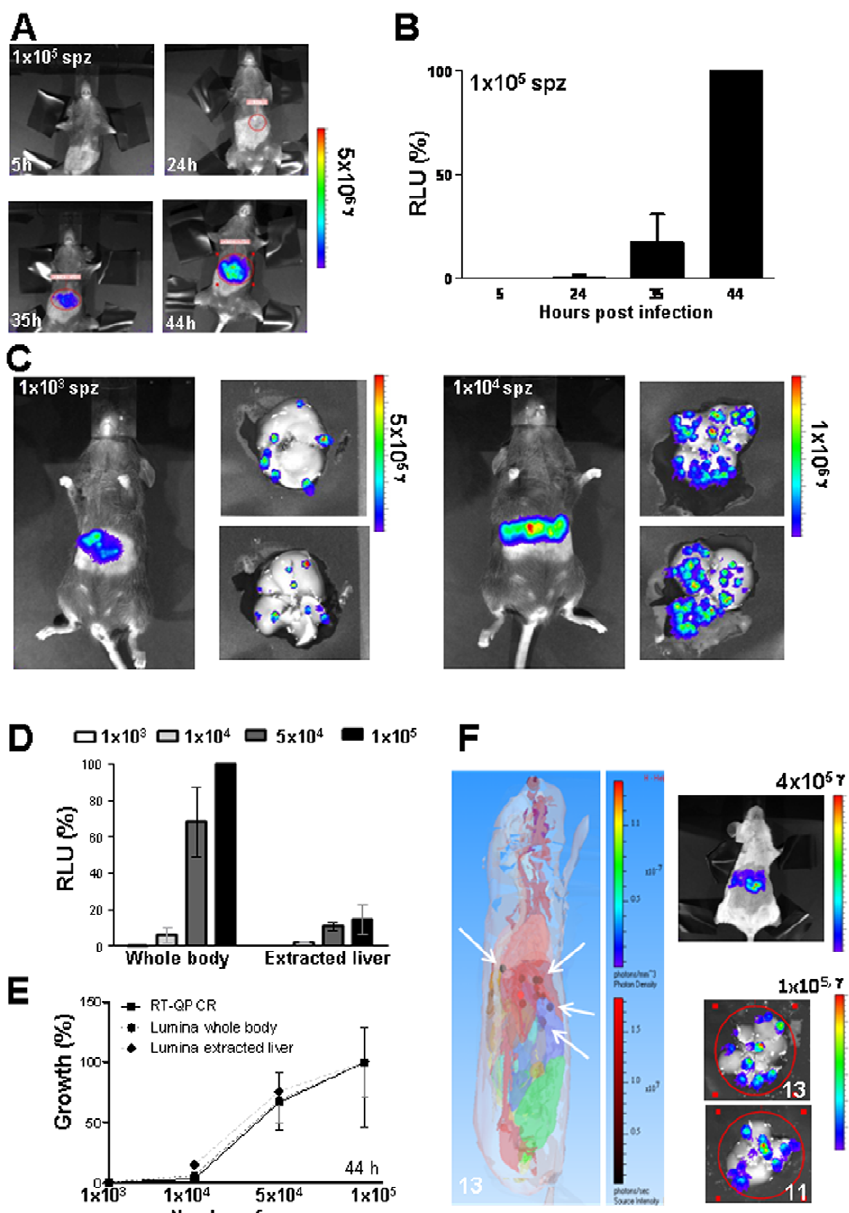
Figure 2. Analysis of invivo liver stage development by determination of luciferase expression (luminescence). A. Representative rainbow images of luminescence in livers of live mice at different time points after injection of 1 6 10 5 sporozoites. Rainbow images show the relative levels of luminescence ranging from low (blue), to medium (green), to high (yellow/red). B. Luminescence levels (photons/sec) of livers in whole mice at different time points after infection with 1 6 10 5 sporozoites (n=4). Photon counts from whole body imaging are expressed as the percentage of the photon counts of mice at 44 h after infection (=RLU %). C. Distribution of luminescence signals in the livers of live mice and in extracted livers of the same mice at 44 h after infection with 1 6 10 3 (left) or 1 6 10 4 (right) of sporozoites. D. Luminescence levels (photons/sec) of whole bodies and extracted livers of mice 44 h after inoculation of different numbers of sporozoites. Photon counts are expressed as the percentage of the photon counts of whole body of mice at 44 h infected with 10 5 sporozoites (=RLU %). E. Correlation between luminescence values as measured by the Lumina system of whole body and dissected livers and of P. berghei 18S rRNA levels as determined by qRT-PCR of dissected livers that are infected with different numbers of sporozoites. The percentage of growth is normalized to the highest reading within each experiment. See Table S2 for the correlation coefficient data of the two-tailed Spearman’s rho test. F. The left panel shows the 3D-imaging of luminescence signals (3D tomography and source reconstruction) in a mouse at 44 h after infection with 5 to 10 mosquito bites as measured with the IVIS 3D Series system. The brown/red spots (white arrows) indicate the origin of highest luminescence intensity in the body. These spots are located in the liver as shown by overlaying with a digital mouse atlas to obtain anatomical reference points (see also Supplementary Movie S1 of mouse 1). The right panel shows the same mouse and its extracted liver (imaged at both sides) imaged with the 2D-IVIS100 imaging system. Numbers in the images represent the number of luminescent spots identified. The number of spots (13) in the whole body is determined by the 3D analysis as can be seen in Supplementary Movie S1.